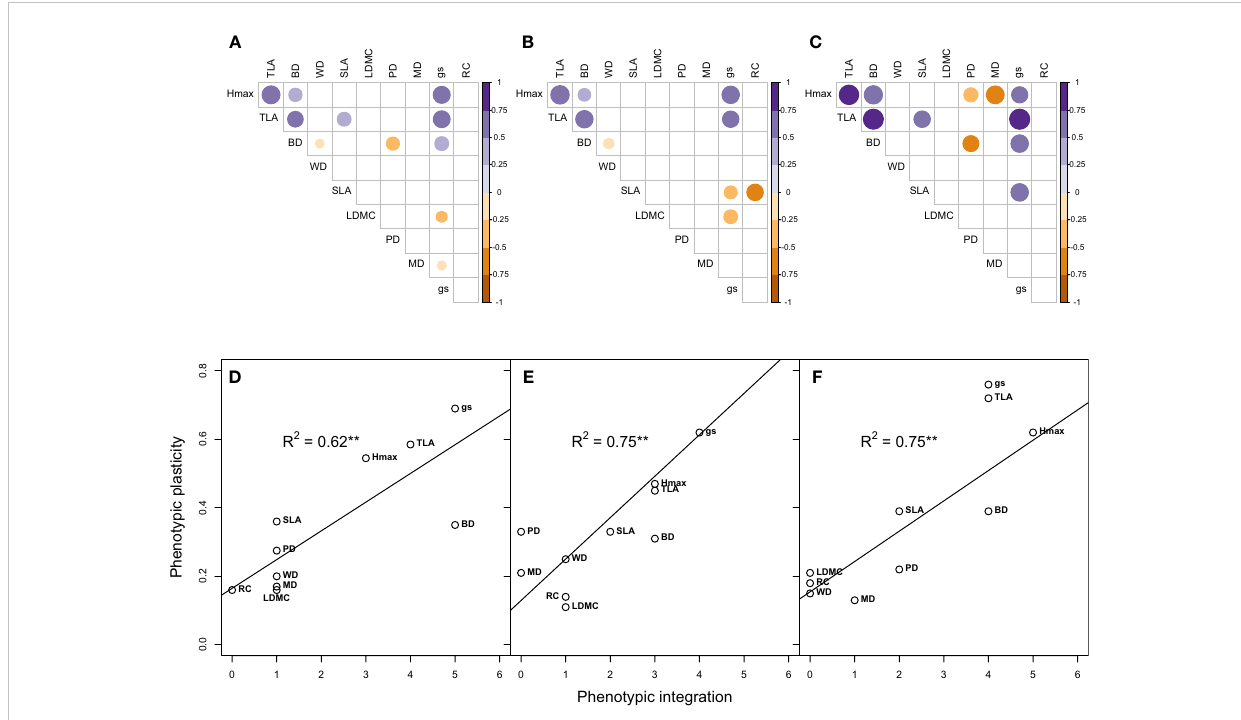
FIGURE 5 Trait integration and its relationship with phenotypic plasticity across wet and dry climate-origin (A, D) , within wet-origin (B, E) and dry-origin (C, F) . Each point represents a trait. Hmax, maximum plant height; gs, stomatal conductance; WD, wood density; PD, predawn water potential; MD, midday water potential; TLA, total leaf area; SLA, speci fi c leaf area; BD, basal diameter and LDMC, leaf dry matter content. R2 adjusted R-squared. Signi fi cant codes: 0 ‘ *** ’ 0.001 ‘ ** ’ 0.01 ‘ * ’